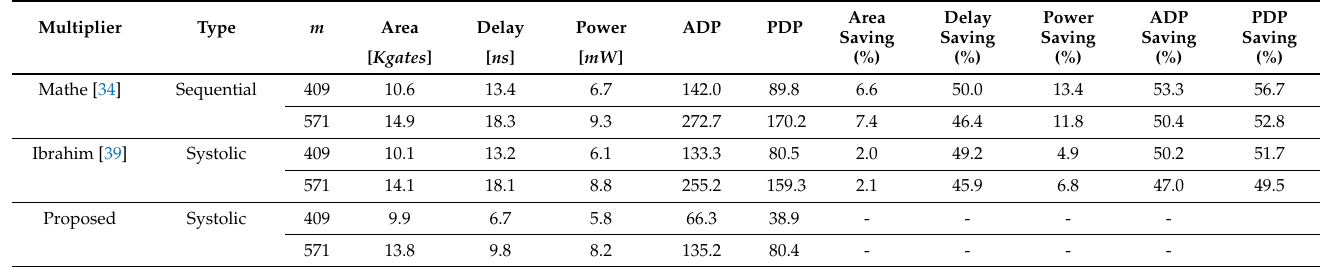
Table 2. Analyzing the performance of different multiplier structures for the values of m = 409 and m =